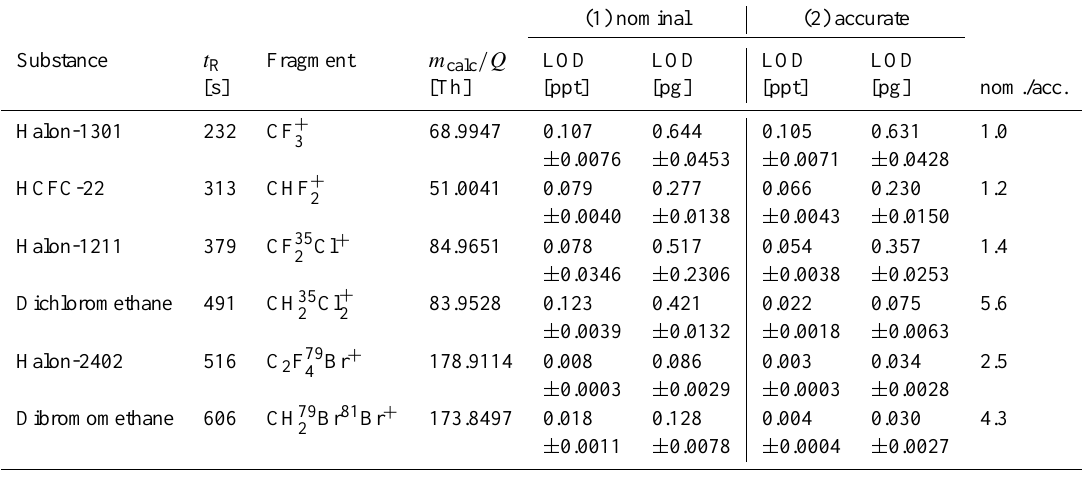
Table 5. Limits of detection for six different species with different retention times and fragment masses: values derived from the analysis of five different air samples calibrated against a secondary standard of the AGAGE network (flask H-218) as well as the calibration gas itself (mean LOD shown). Sample volume was extrapolated from approximately 490mL to 1L. LOD were calculated based on an evaluation of the respective (1) nominal and (2) accurate mass intensities (see Sect. 2.4 for details). Errors were derived from mean errors of noise and height calculation for each sample. The ratio of nominal mass LOD to accurate mass LOD is shown in the last column.